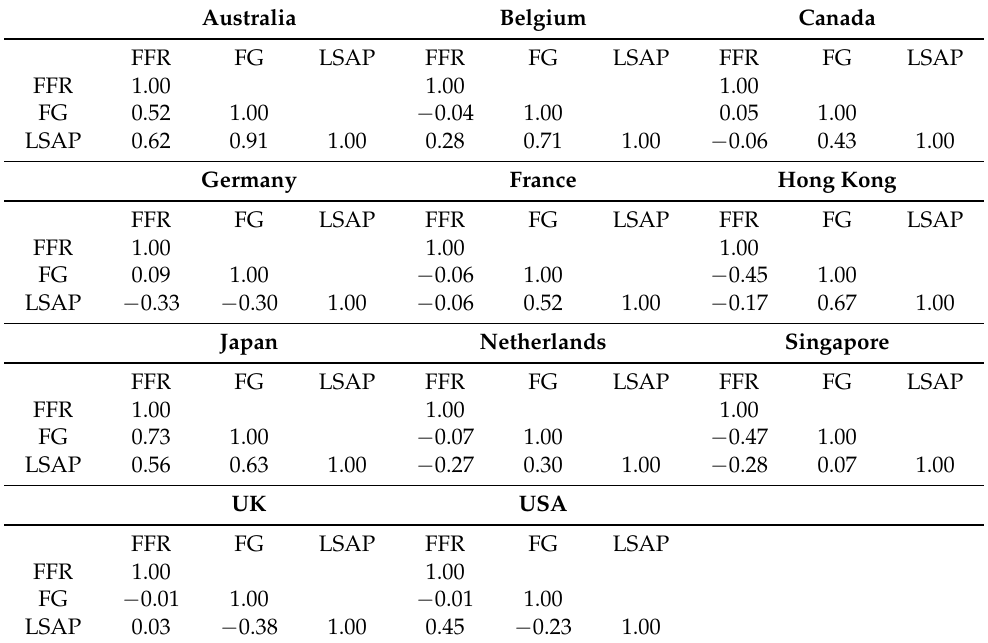
Table 2. Correlation matrix: TVP impact. The table presents correlation matrix of the TVP response of REIT to each monetary policy shock, that is, federal funds rate (FFR), forward guidance, (FG), and large scale asset purchases